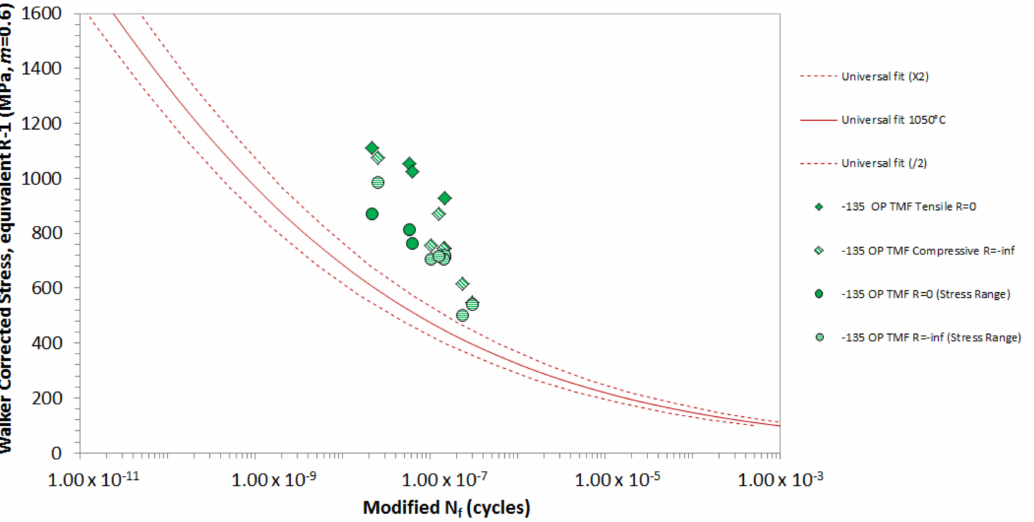
Figure 10. − 135 ◦ OP TMF for ∆ T = 350 ◦ C–1050 ◦ C, plotted using the original TMF lifing model used for IP and OP TMF.